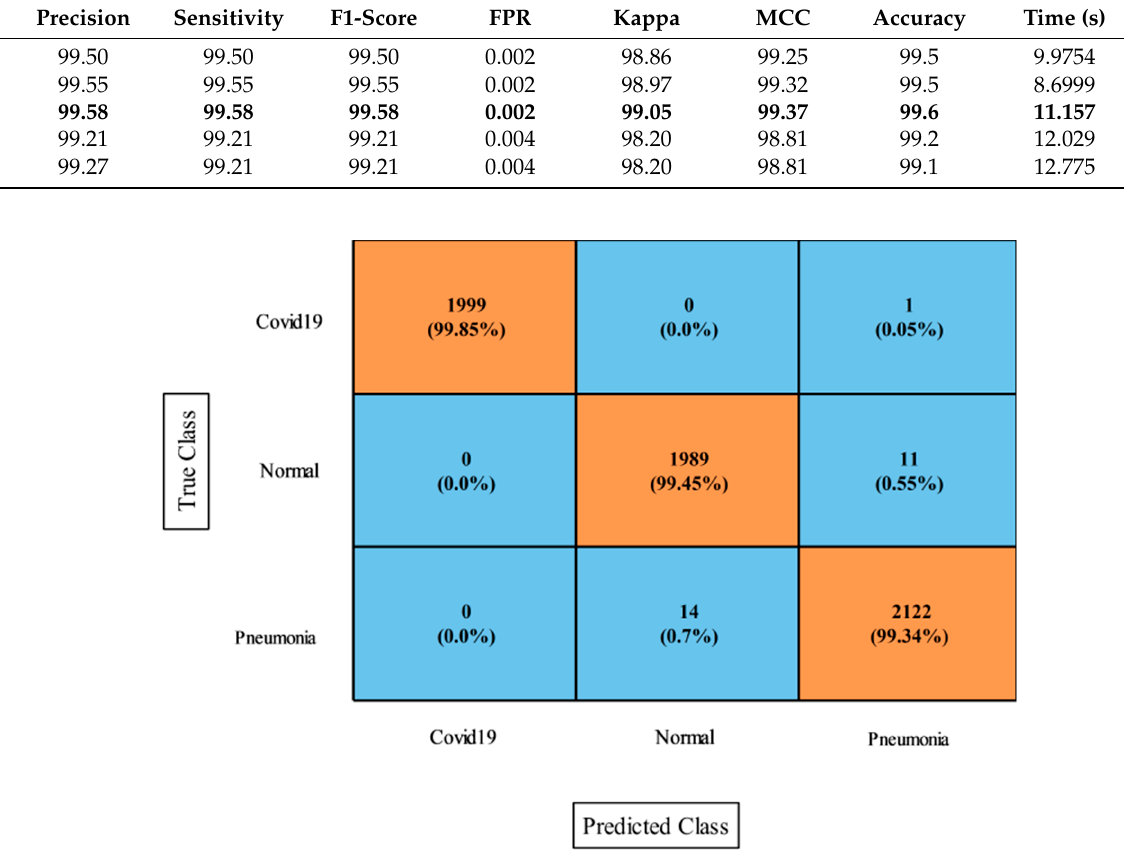
Figure 7. Confusion matrix WNN for proposed improved tree growth optimization method on Chest X-ray dataset.